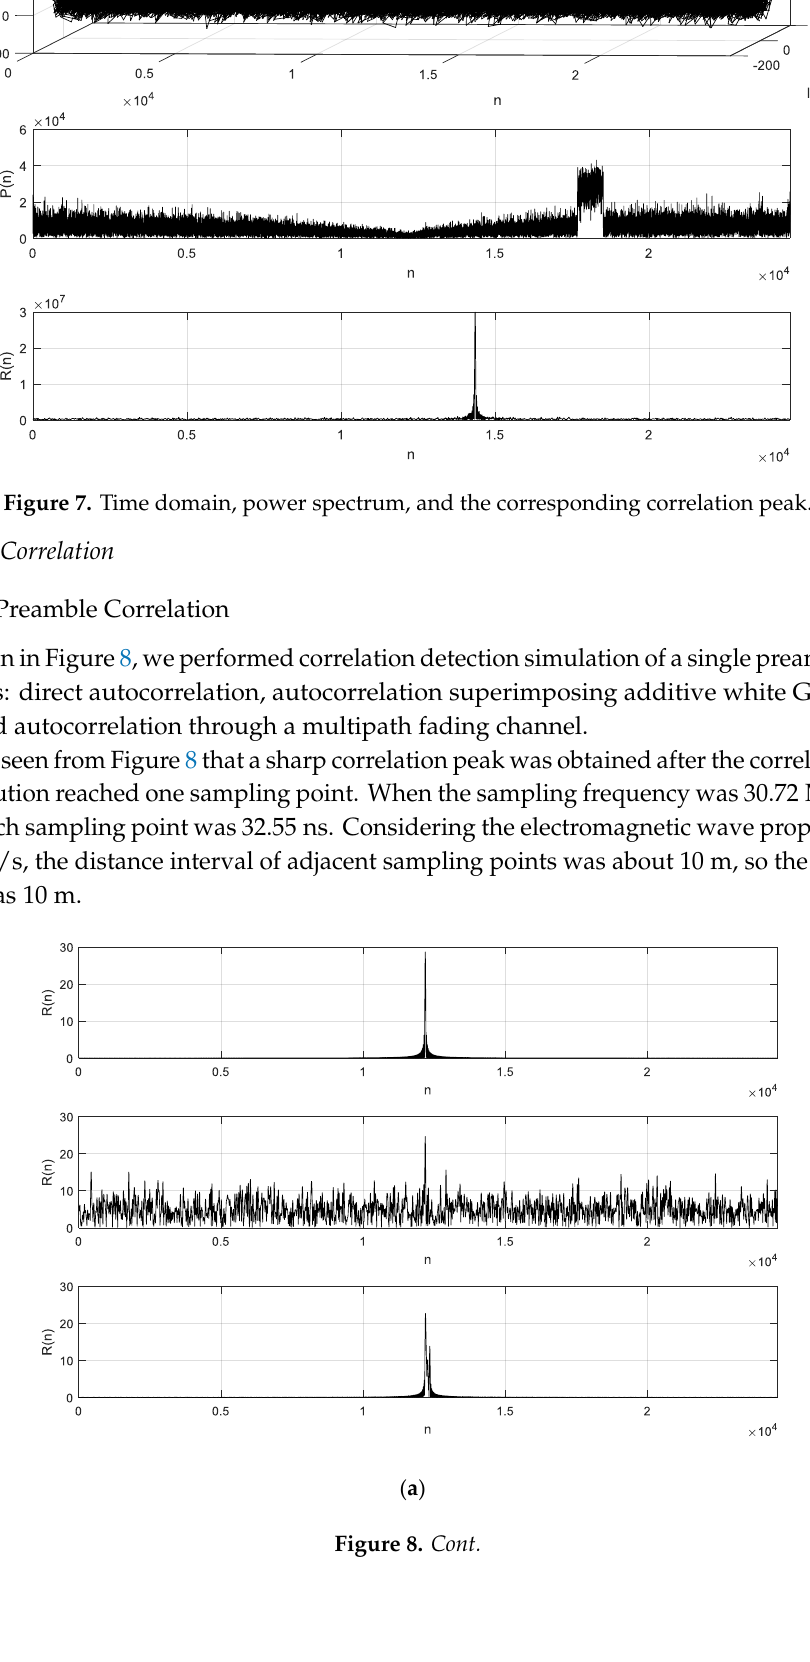
( b ) Figure 8. Preamble sequence correlation peak: ( a ) all points and ( b ) part of the points. It can be seen from Figure 8 that a sharp correlation peak was obtained after the correlation analysis, and the resolution reached one sampling point. When the sampling frequency was 30.72⁡ MHz , the time interval of each sampling point was 32.55⁡ ns . Considering the electromagnetic wave propagation speed of 3⁡ ×⁡ 10 8 ⁡ m/s , the distance interval of adjacent sampling points was about 10⁡ m , so the measurement resolution was 10⁡ m . Figure 9 shows the probability of being within different ranging errors at sampling rates of 15.36 , 30.72 , and 61.44⁡ MHz under −20 and −30⁡ dB signal-to-noise ratio (SNR). When the SNR was −20⁡ dB , the probability of ranging error within 20⁡ m was more than 95%, so distance measurement accuracy within 20⁡ m could be achieved. Although the ranging error was greatly increased when the SNR was −30⁡ dB at the same sampling rate, the signal was still detected. Using